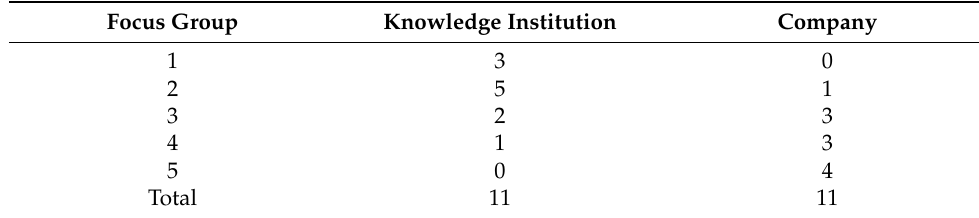
Table 1. Focus group composition. Focus